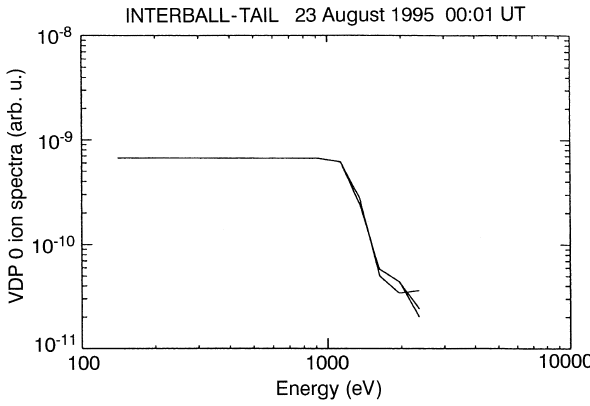
Fig. 3. Example of measured integral energy spectra of a solar-wind